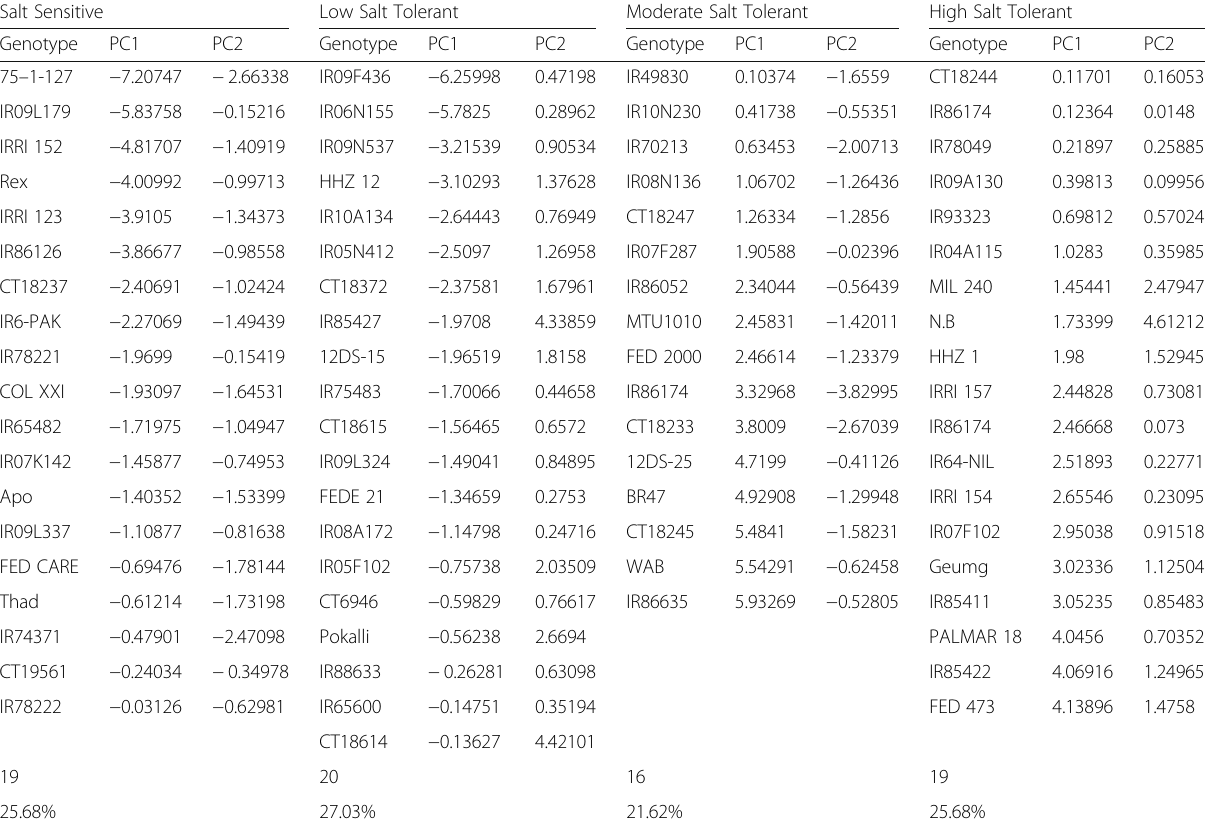
Table 3 Classification of 74 rice genotypes based on the principal component analysis (PC1 vs. PC2) of morpho-physiological parameters at the seedling stage and the variation accounted by each eigenvector Salt